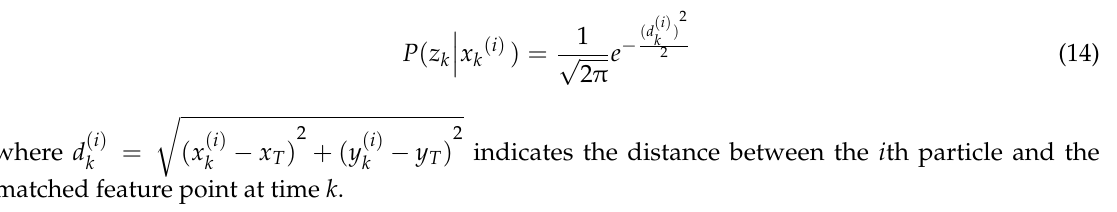
indicates the distance between the i th particle and the